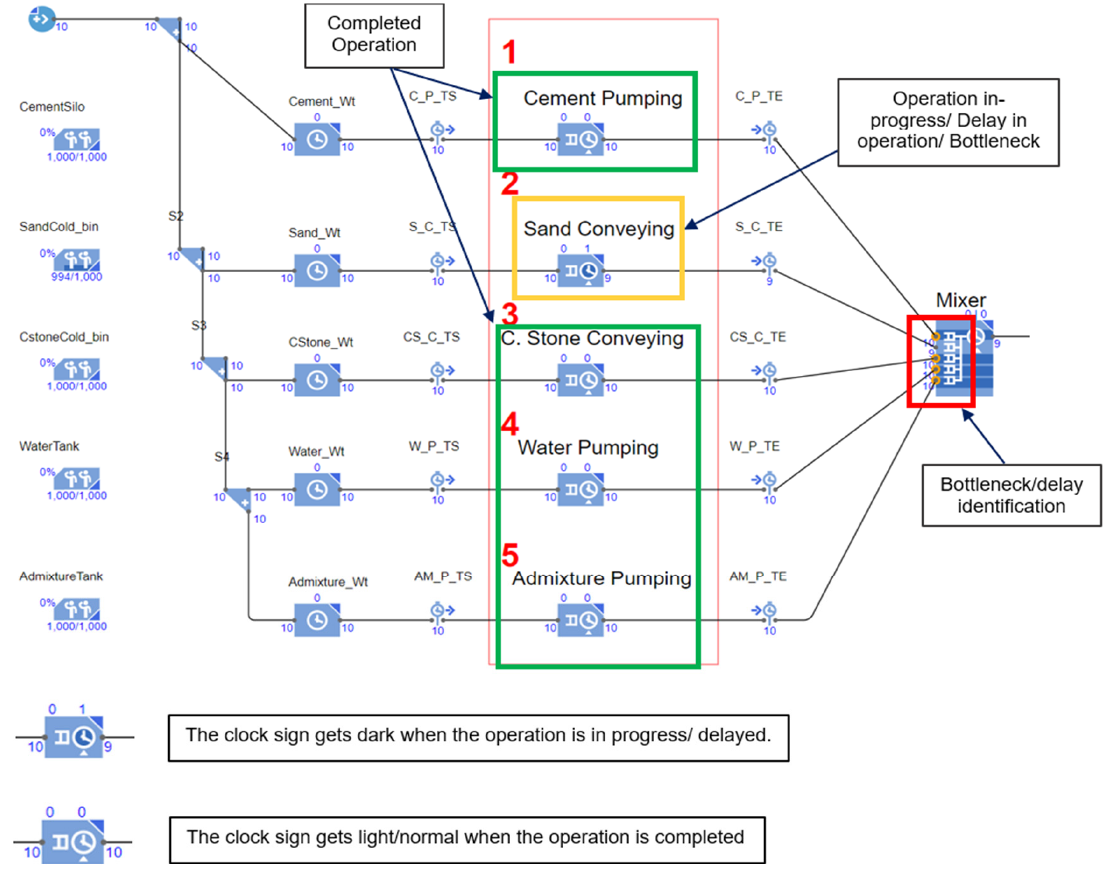
Figure 16. Digital Twin Process Bottleneck Detection. Table 7. Actual vs. standard cycle time difference for each production process.